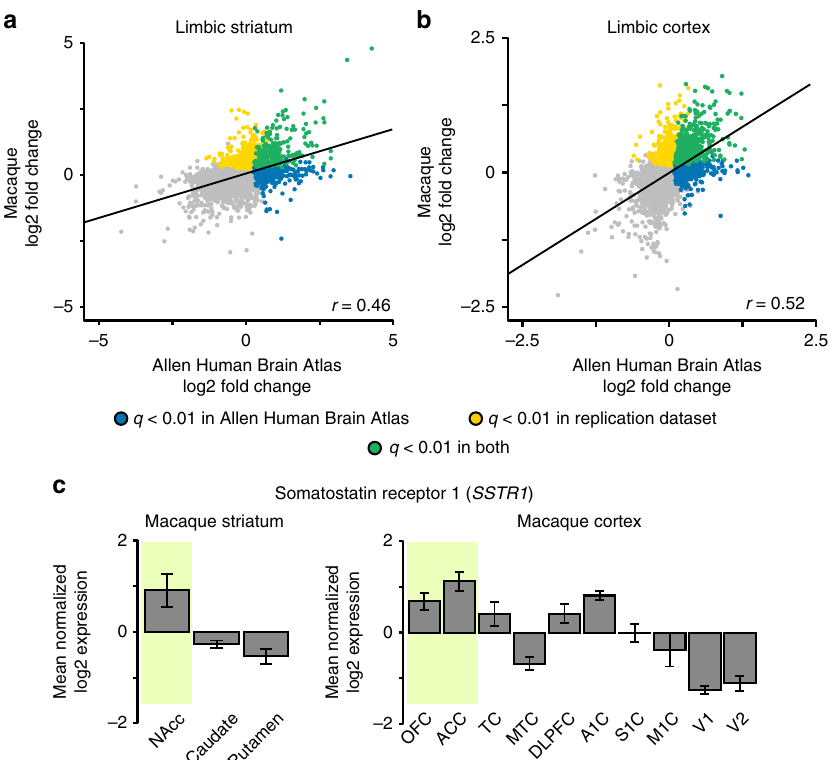
Fig. 7 Differential expression in limbic cortical and striatal networks is conserved in non-human primates. a Microarray data from the NAcc, putamen, and caudate of six adolescent and young adult macaque primates were obtained from the NIH Blueprint Non-Human Primate atlas. Gene-wise differential expression (i.e., log2 fold change) in Blueprint non-human primate NAcc, relative to caudate and putamen, was positively correlated to differential expression in human AHBA limbic striatum, r = 0.46, p ≤ 0.001). b Cortical microarray data for six adult macaque primates sampling ten cortical brain regions were obtained from the study by Bernard et al. 28 . Gene-wise log2 fold change in primate limbic cortex (i.e., OFC, ACC) was positively correlated to fold change in the AHBA limbic cortical region, r = 0.52, p ≤ 0.001). c Somatostatin receptor 1 ( SSTR1 ) was expressed most within limbic cortex and striatum of the macaque. Error bars re fl ect ± 1